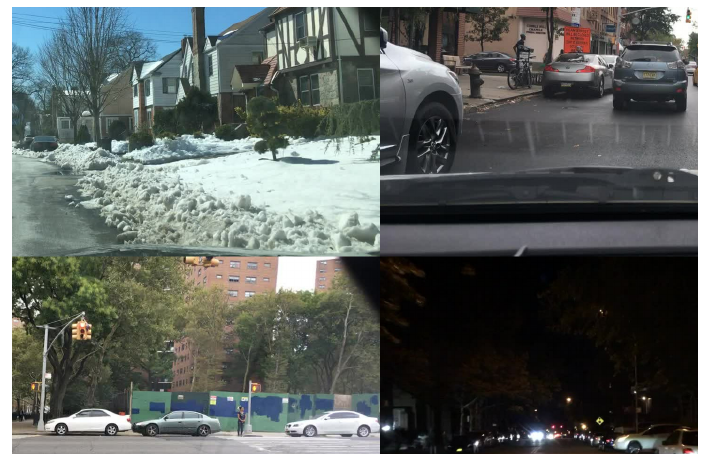
Figure 6. A mosaic example made up of four